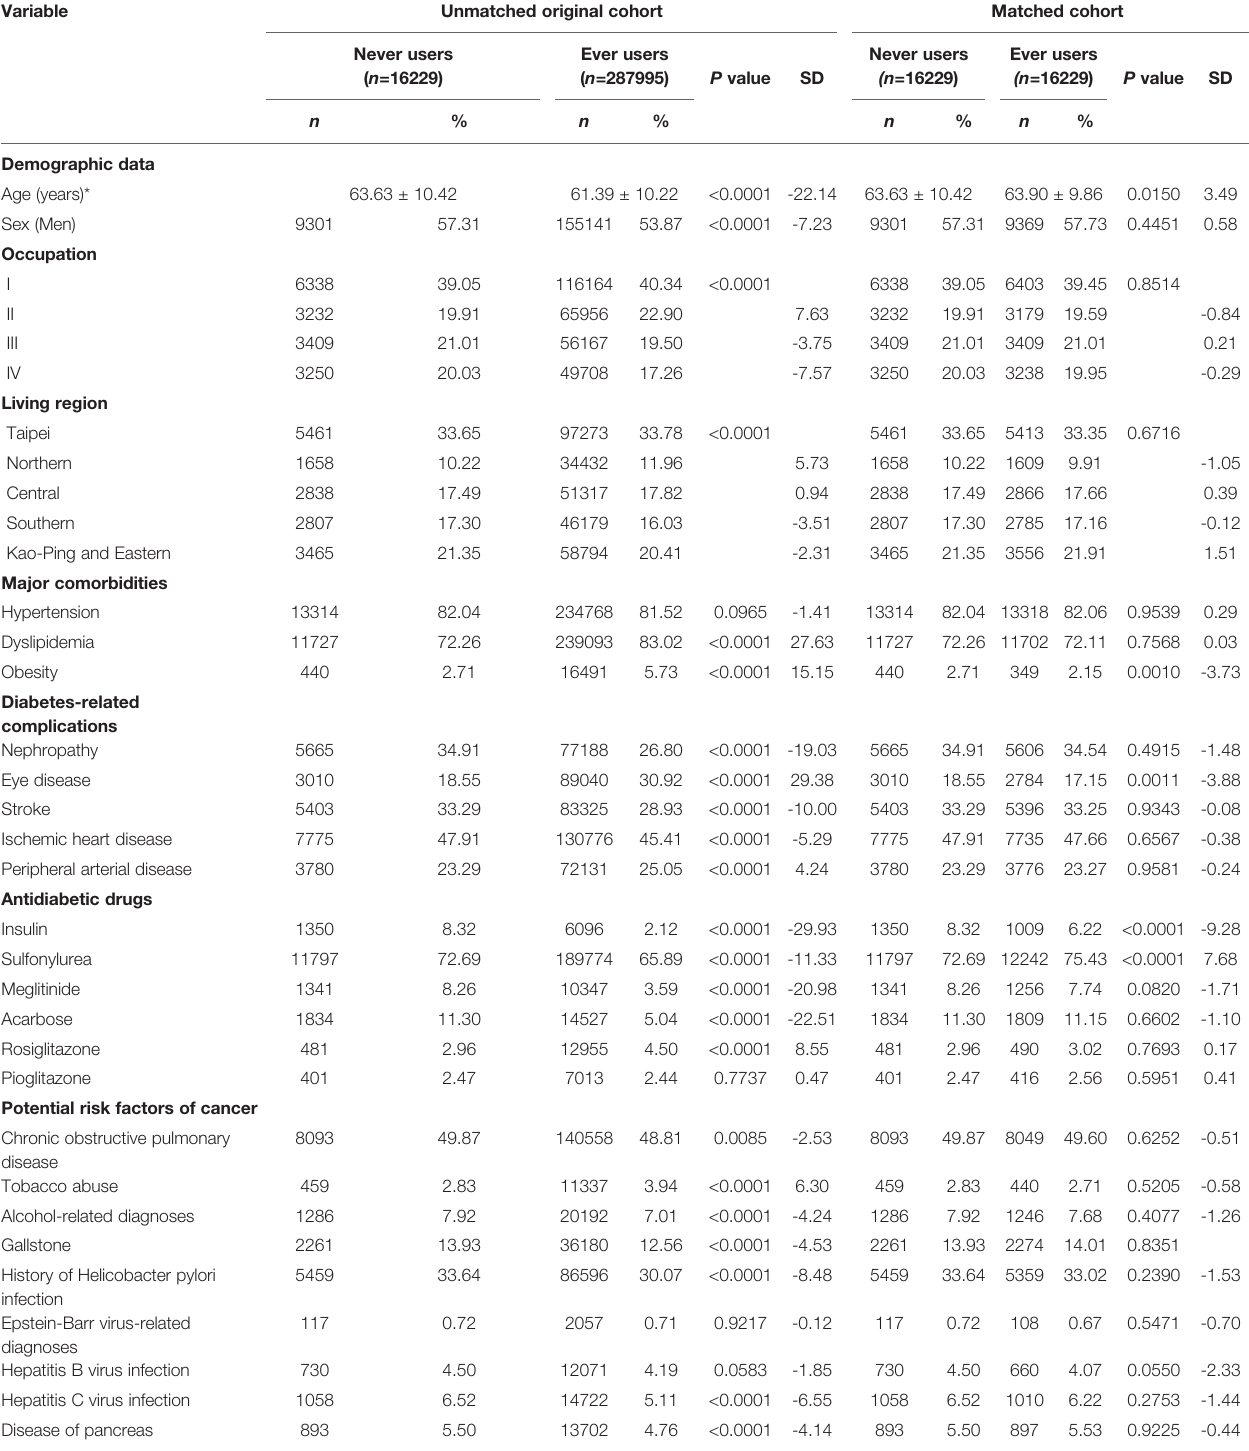
TABLE 1 | Characteristics in metformin never users and ever users in the unmatched original cohort and in the propensity score matched cohort.